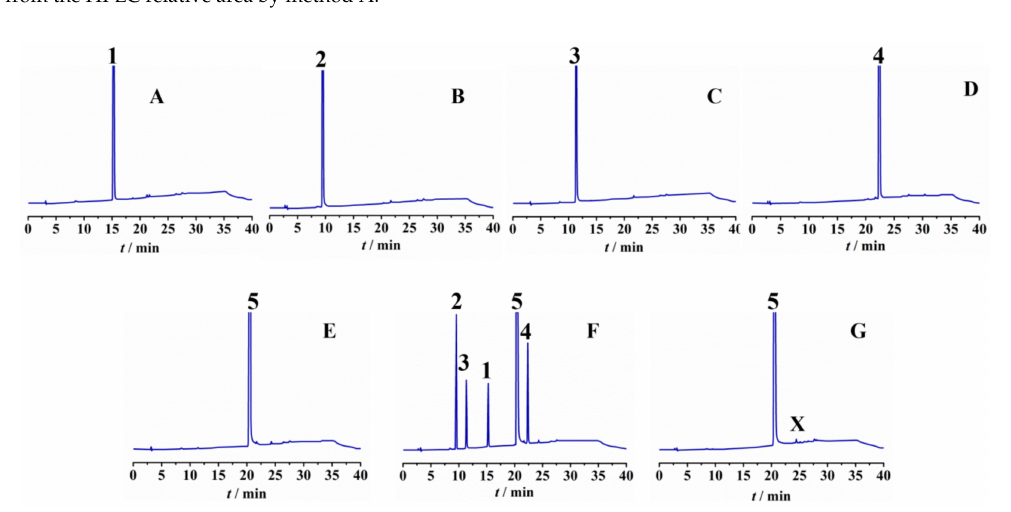
Figure 1. Detection of related substances of LM49-01 by HPLC method A. ( A ) SM01 reference substance. ( B ) SM02-imA reference substance. ( C ) SM01-imA reference substance. ( D ) LM49-01-imA reference substance. ( E ) LM49-01 reference substance. ( F ) SM01 / SM02-imA / SM01-imA / LM49-01-imA / LM49-01 reference substance mixture. ( G ) LM49-01 test sample. X: Unknown single impurity LM49-01-imX